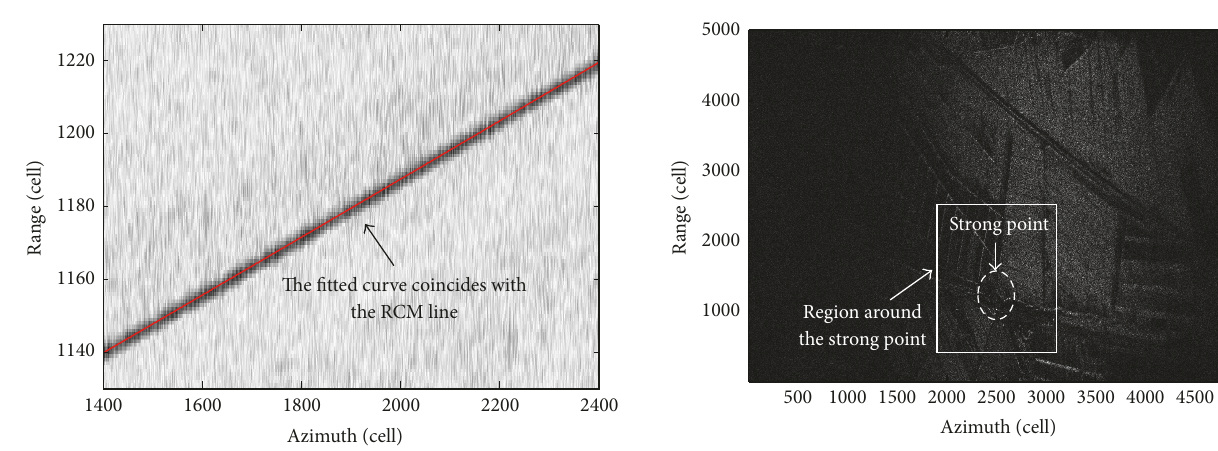
Figure 10: Curvefitting result (bistaticradar). The fitted curveis still coincident with the RCM line (100% for strong points in echo).